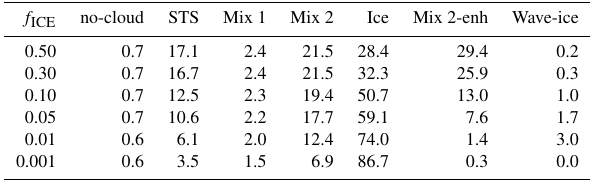
Table 3. MIPAS-like PSC types partitioning for CALIOP with respect to ice fraction ( f ICE ) ; f ICE = 0 . 5 represents a fraction > 50%; type contribution is given in